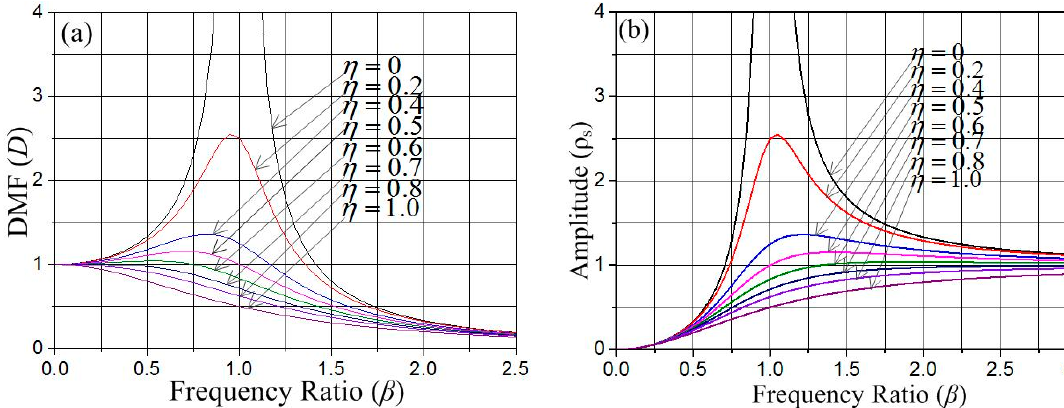
Figure 5. ( a ) The dependence of factor D on the frequency ratio β . ( b ) The dependence of amplitude ρ s on the frequency ratio β .